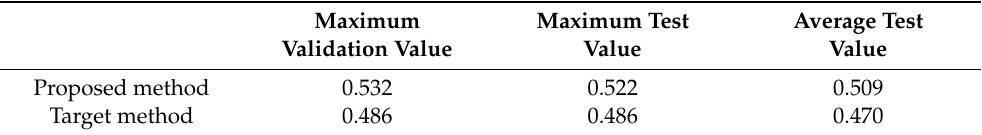
Table 1. Comparative analysis of the maximum and average values between the proposed method and target method when there are 800 bits of random numbers.